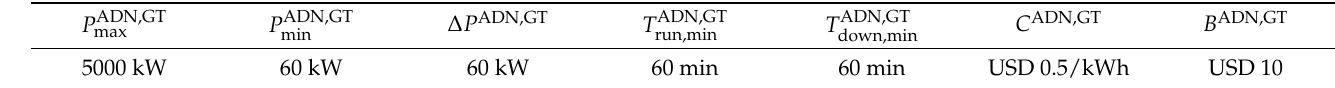
Table A6. Parameters of gas turbine (ADN).